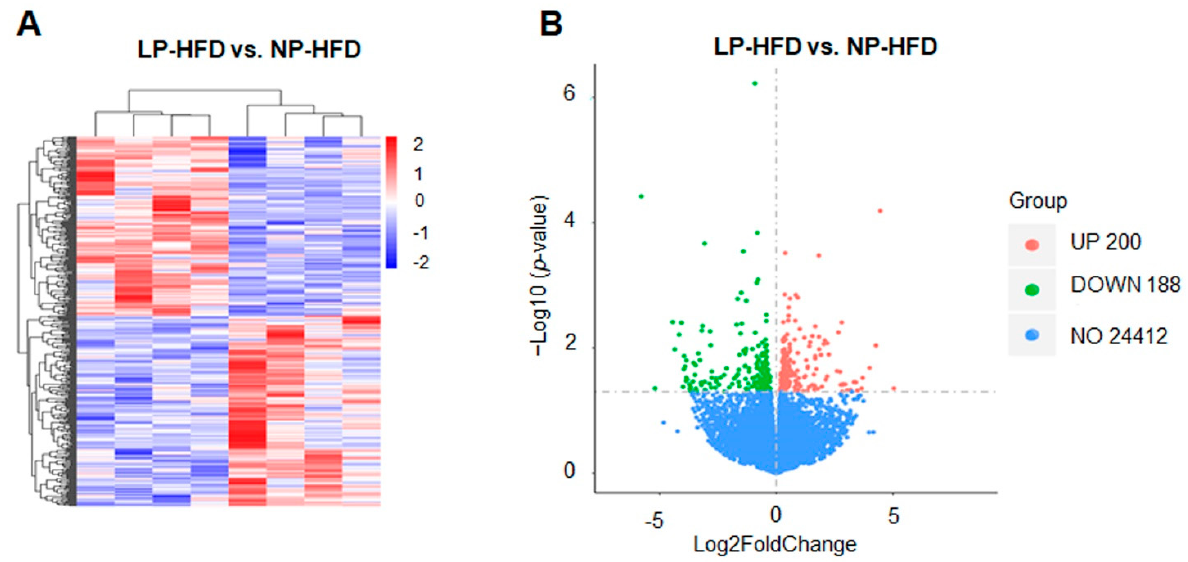
Figure 3. Analysis of DEGs in the liver between LP-HFD and NP-HFD groups. Transcriptome anal- ysis was performed with the liver of LP-HFD and NP-HFD offspring. RNA-seq libraries were pre- pared with total RNAs extracted from liver tissues, and sequencing was carried out on Illumina Hiseq platform. The final data were analyzed by the DEseq2 R software. ( A ) Heatmap clustering was analyzed with differentially expressed genes between the LP-HFD and NP-HFD groups. ( B ) The threshold for differential expression genes (cut-off = |log2 Fold Change| > 0 and p -value < 0.05) is indicated by dashed black lines. Solid red and green dots represent the up-regulated and down- regulated genes, respectively. n = 4 for each